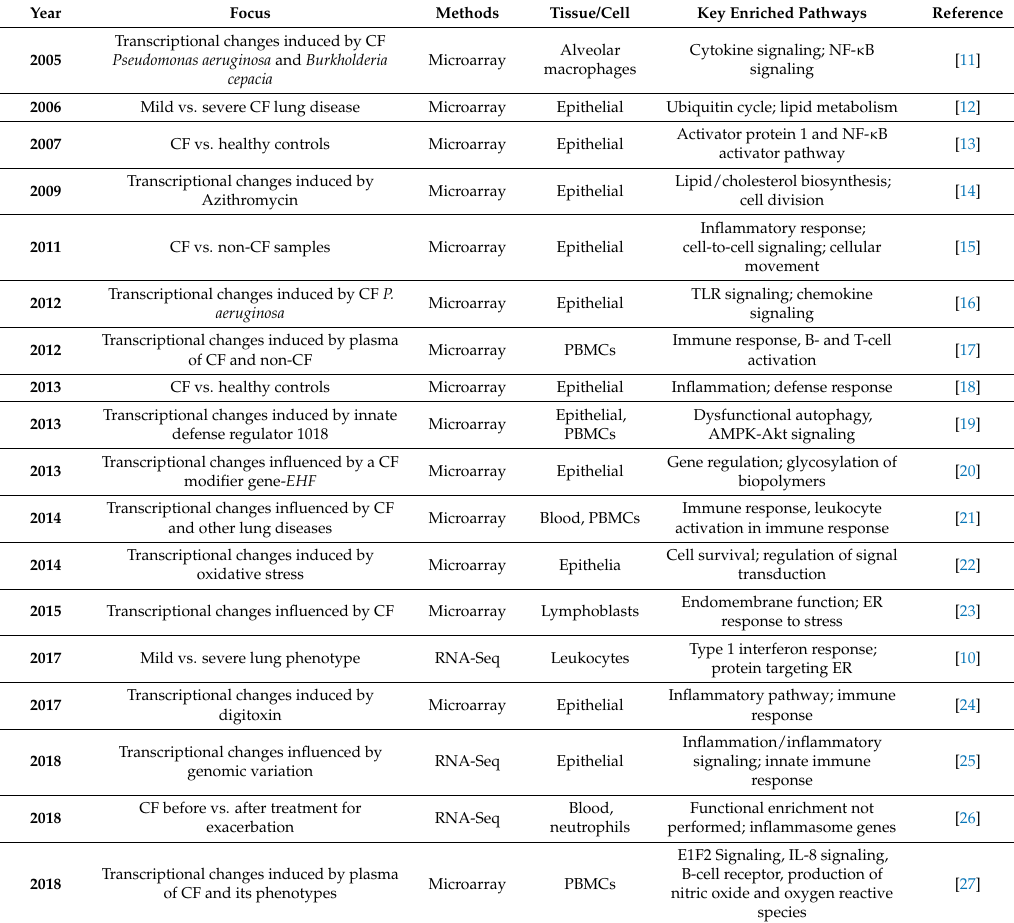
Table 1. Summary of human transcriptome profiling studies in cystic